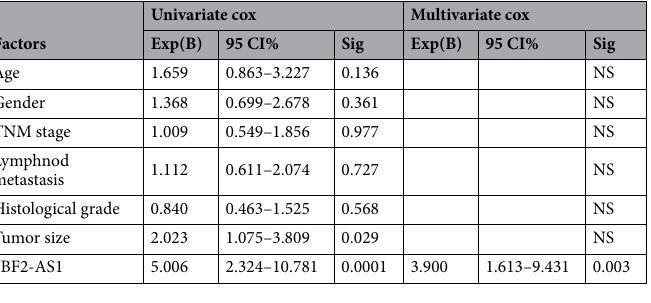
Table 2. Multivariate analysis for overall survival by cox regression model.